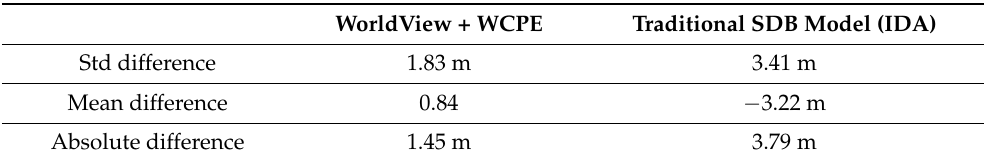
Table 2. Differences between the WCPE and the traditional SDB model against the Tahanea ground truths (WorldView).